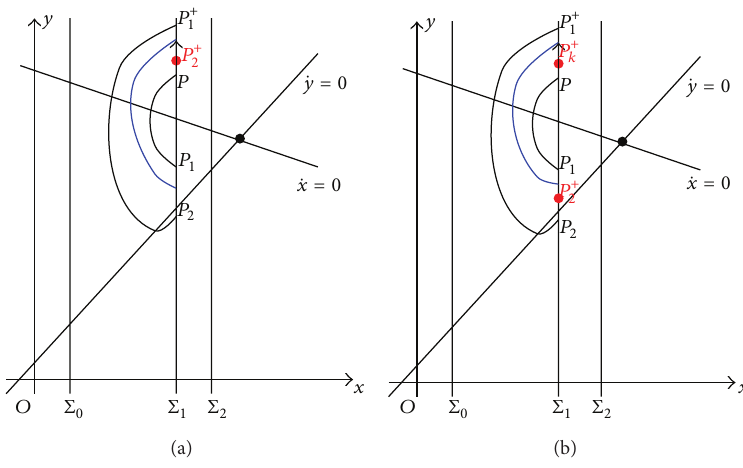
Figure 2: The possible trajectories in the case of (1 − 𝛼)ℎ 2 < ℎ 1 < ℎ 2 < 𝑥 ∗ .